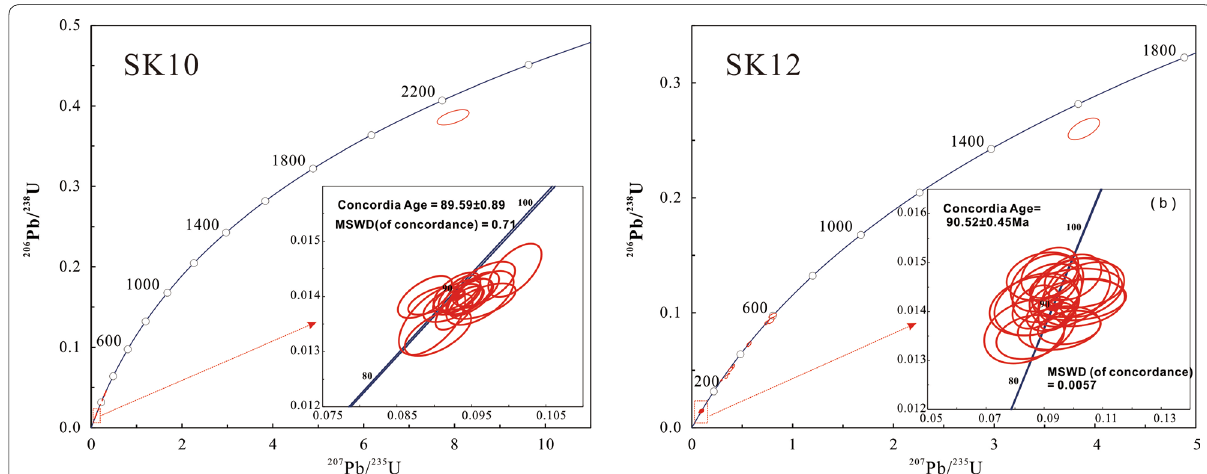
Fig. 8 U–Pb concordia age (calculate from 206 Pb/ 238 U ages) and age spectrum diagrams of the leucogneiss samples